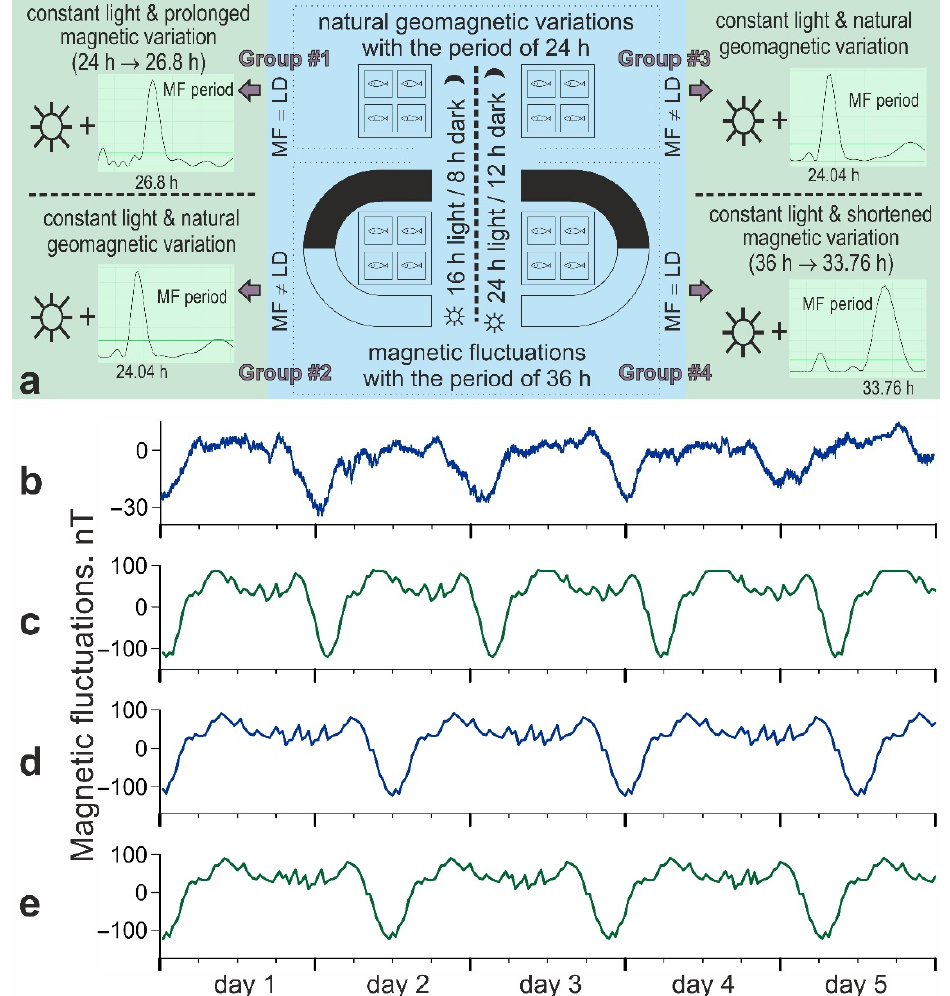
Figure 1. Scheme of the experiments ( a ) and magnetic fluctuations applied to zebrafish ( b – e ): natural diurnal geomagnetic variation, averaged from several 5-day periods in time-separated replications ( b ); magnetic variation with 26.8 h period used at the second stage of experiments, extended relative to the initial 24 h period ( c ); magnetic variation with 36 h period used at the first stage of experiments ( d ); magnetic variation with 33.76 h period used at the second stage of experiments, shortened relative to the initial 36 h period ( e ).